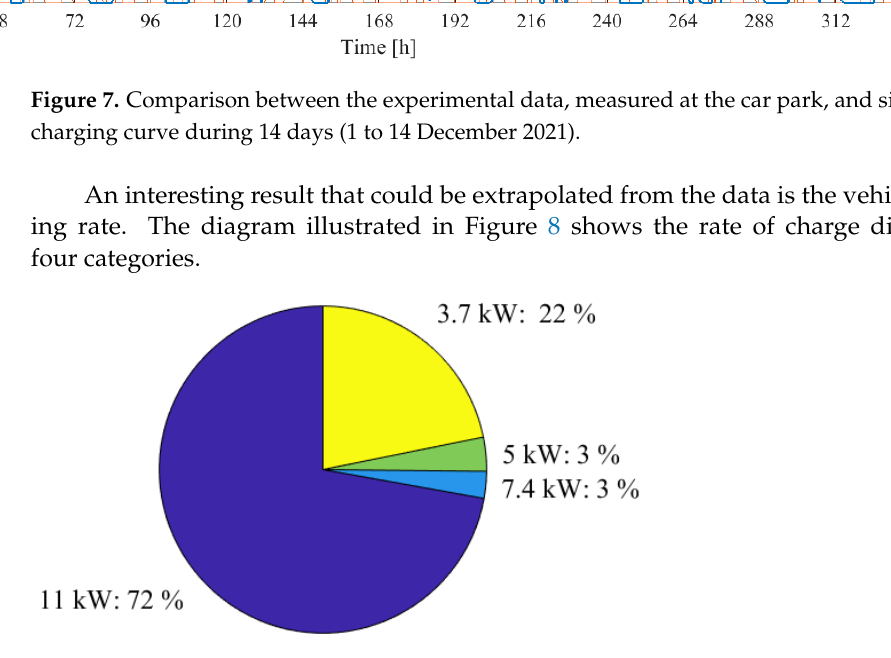
Figure 9. Base load for 2021. Comparison between the experimental data, measured at the car park, and the simulated data. A zoom in on the green squares is plotted for 13 winter days and 13 summer